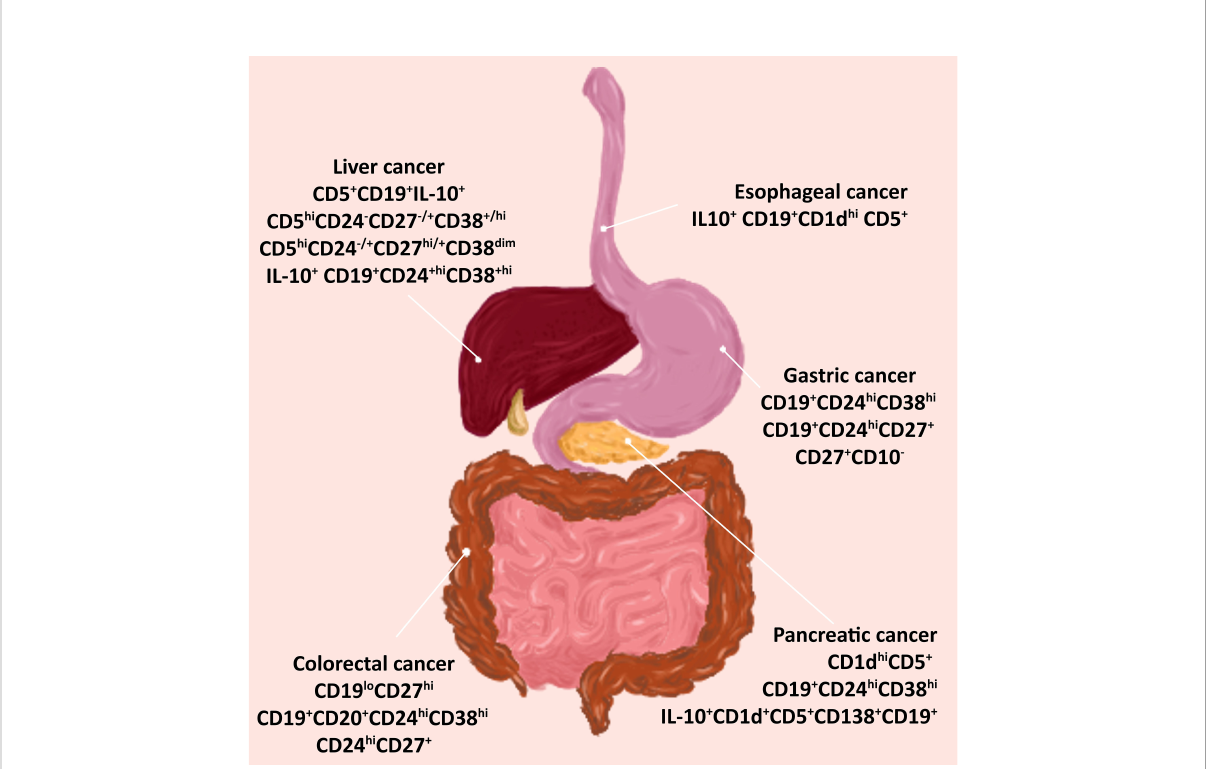
FIGURE 3 Bregs phenotypes in cancers associated with the digestive tract. Tumor-in fi ltrating Bregs were found in the most common types of cancer of the gastrointestinal tract. Various phenotypes have been detected in tumors of the esophagus, stomach, colon, pancreas, and liver. Abbreviations: Bregs, regulatory B cells